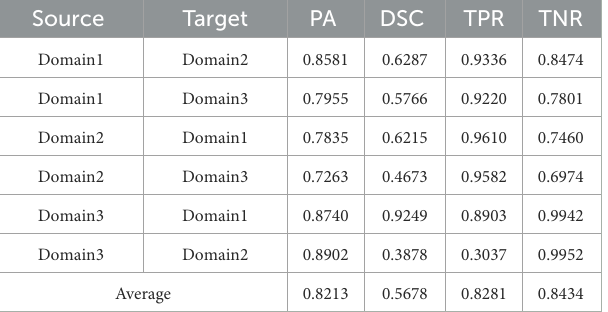
TABLE 6 esults on ultrasound thyroid nodule datasets with SegM + AUG.